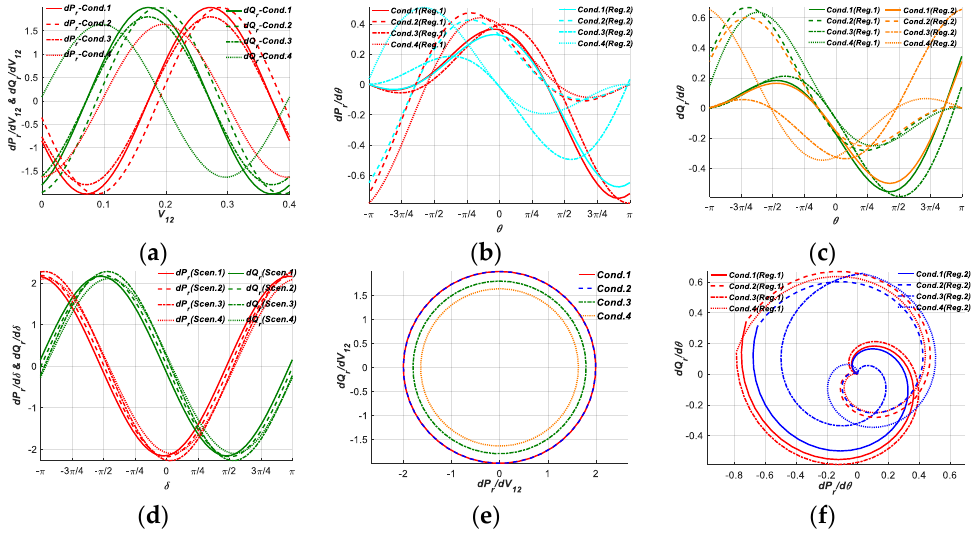
Figure 11. Curves of PFG to each CIV at SCP4 in planes: ( a ) Curves of the PFG to CIV1; ( b ) Curves of the APFG to CIV2; ( c ) Curves of the RPFG to CIV2; ( d ) Curves of APFG and RPFG to CIV3; ( e ) Curves of APFG against RPFG to CIV1; ( f ) Curves of APFG against RPFG to CIV2.